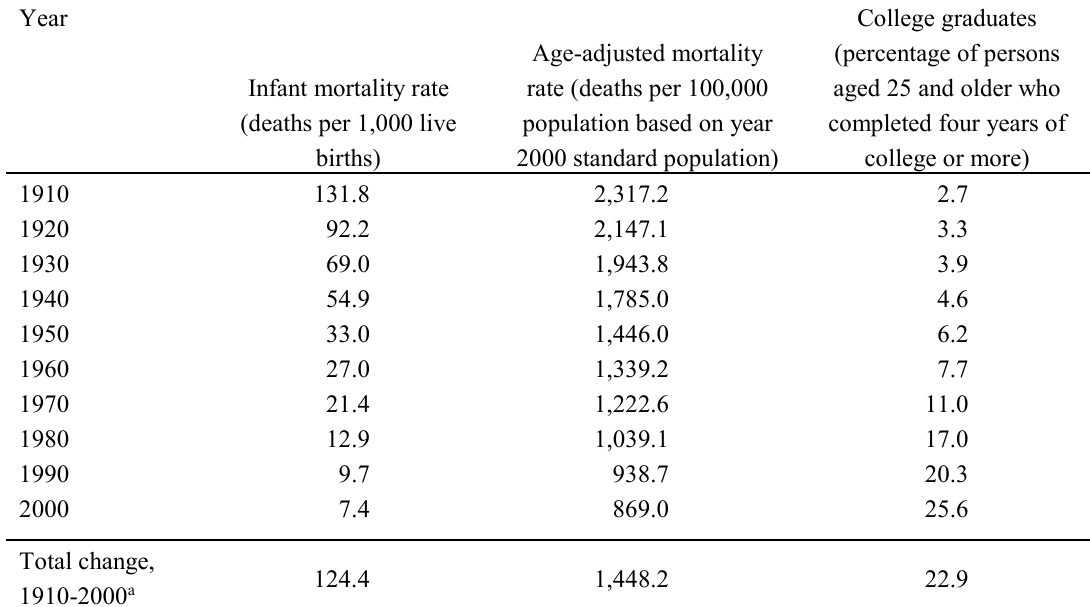
Infant mortality rate, age-adjusted mortality rate, and educational attainment, United States, selected years,